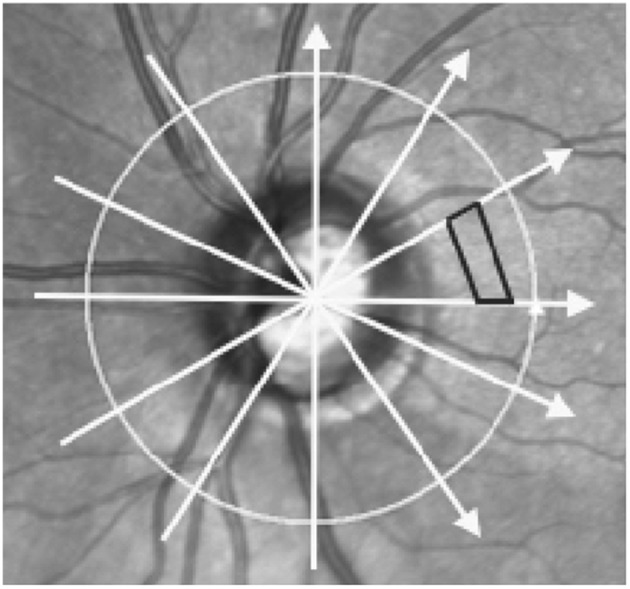
Scan pattern used to acquire optic nerve head images and method of volume calculation. Image shows a scanning Laser Ophthalmoscopy image of the optic nerve head and surrounding areas. Arrows represent the scan locations of the 6 radial optical coherence tomography (OCT) B-scans centered on the optic nerve head. Black trapezoid demonstrates how volume was interpolated between adjacent B-scans. Each volume was the sum of 510 trapezoidal prisms calculated in each of the 12 wedges formed by intersecting B-scans.